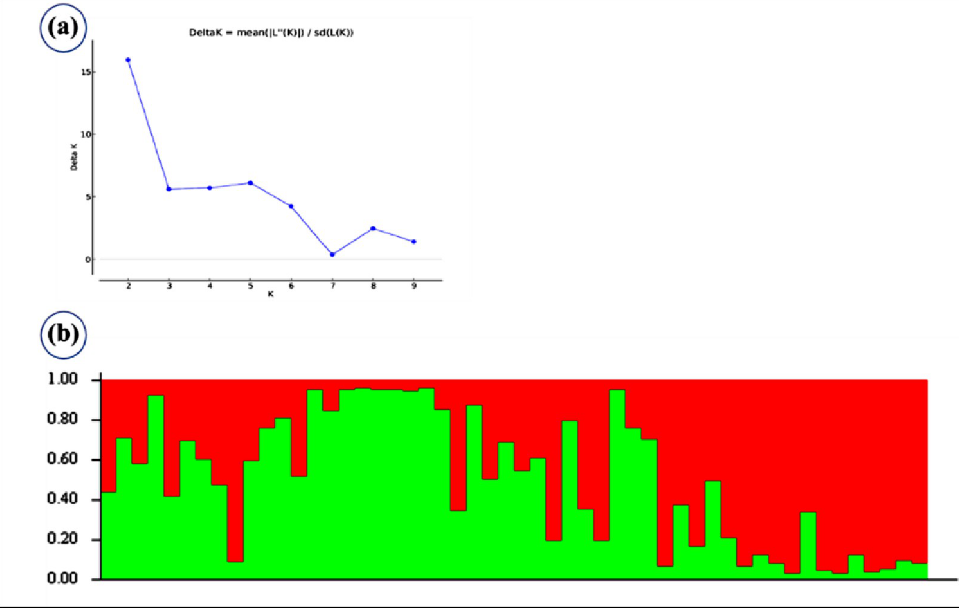
Fig 2. Population structure analysis of 52 rice genotypes (a) The maximum of ad hoc measure Δ K was observed to be K = 3 (b) Estimated population structure graph separated the whole population into two